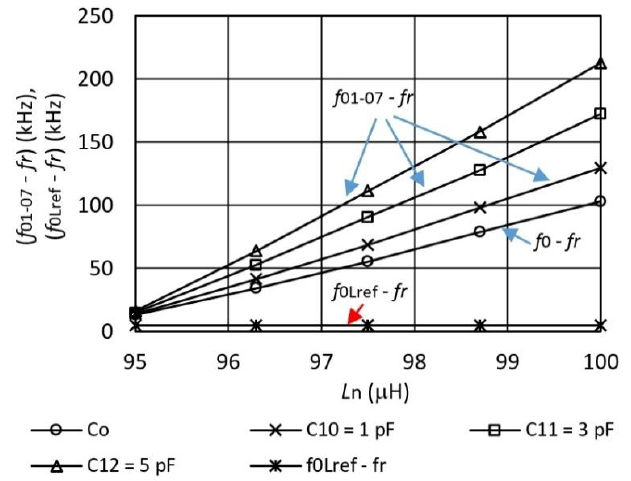
10 of 14 Figure 5. Inductance-frequency characteristics f 01-07 for inductance settings in steps of 0 μH, 12 μH, 25.4 μH, 48 μH, 75 μH, 85 μH, 95 μH, 97.5 μH, and 100 μH (for different values of capacitance C 10 – C 12 in parallel to the crystal at T = 25 °C). Figure 6 shows in greater detail inductance-frequency characteristics in the range of inductance- frequency switcher operation when the inductance is changed in the range L n = 95–100 μH. By using a switching multiplexer (and switching signals sent by wires S 1 –S 3 ) (Figure 3), where various inductances L n are switched, we get characteristics f 01–07 − f r and f 0Lref − f r . Depicted are three different characteristics for three different capacitance values C 10 – C 12 , which are switched with the digital signals sent by wires IN 1 –IN 3 (in the range 1, 3, and 5 pF) and characteristics C 0 (when the crystal does not have any additionally connected capacitance in parallel). Frequency difference f 0Lref − f r = 5 kHz is determined by the reference inductance L ref (Figure 3) and the OCXO reference oscillator, and serves for the transformation of the signal in the lower frequency range and for the temperature compensation.